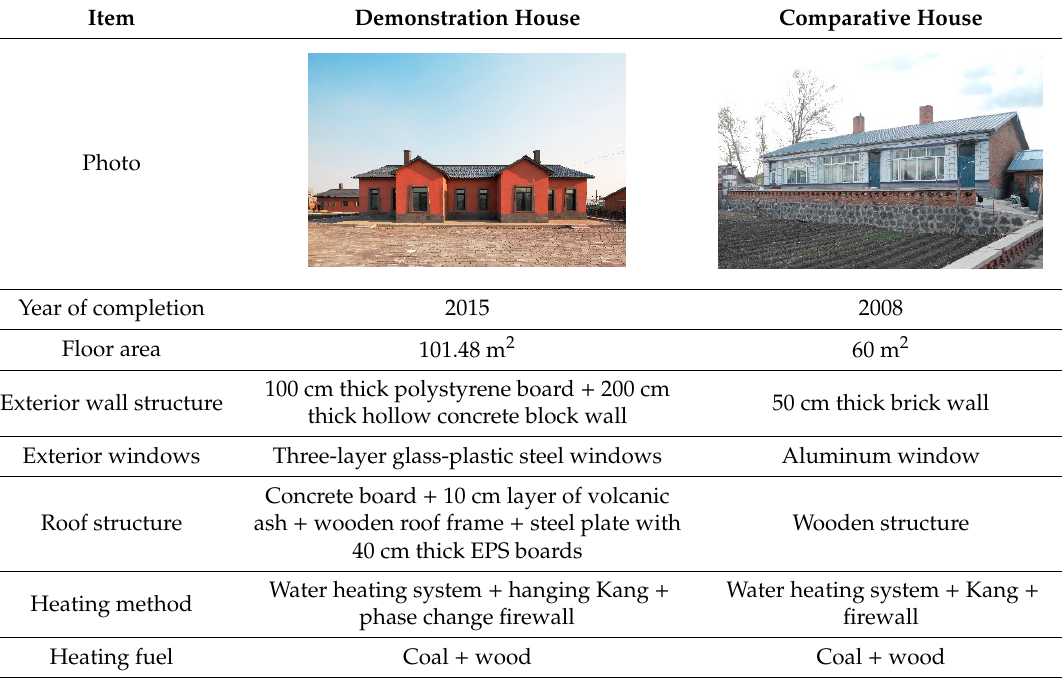
Table 3. Information on the demonstration house and comparative